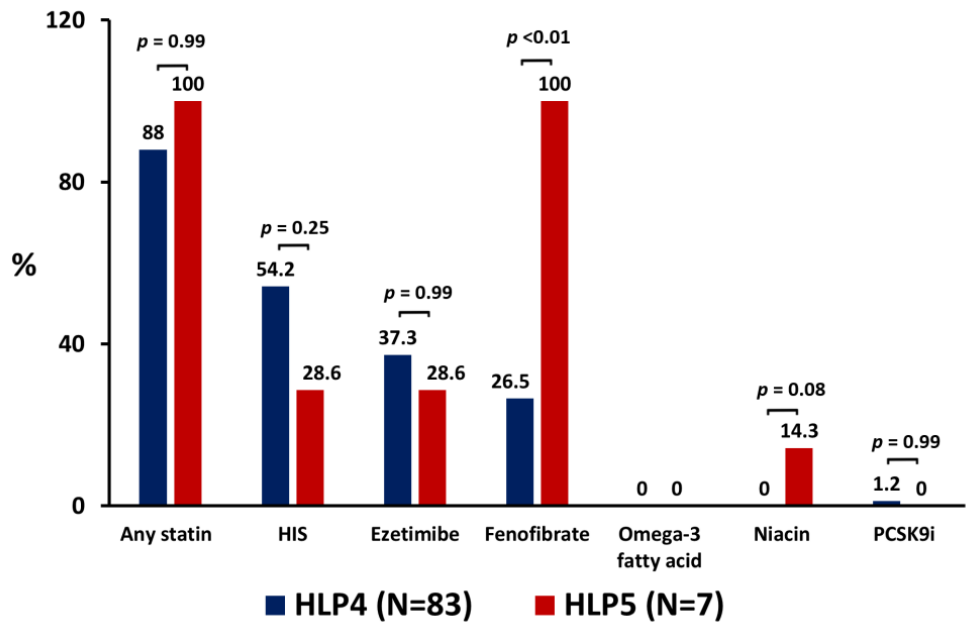
Figure 1. Prescription rates of LLT in patients with HLP4 and patients with HLP5 at the 6-month follow-up. HIS = high-intensity statin; HLP4 = type IV hyperlipoproteinemia; HLP5 = type V hyperlipoproteinemia; LLT = lipid-lowering therapy; N = number; PCSK9i = proprotein convertase subtilisin/kexin type 9 inhibitor ( p value was calculated as HLP5 vs. HLP4). There were no patients lost follow-up during the 6-month observation. Only one pa- tient with HLP4 had no data of plasma LDL-C, HDL-C, and apoB levels at the 6-month follow-up. Following 6 months of treatment, patients with HLP5 had similar TC (173.4 ± 35.5 mg/dL vs. 150.0 ± 36.1 mg/dL; p = 0.09), LDL-C (79.4 ± 35.4 mg/dL vs. 79.8 ± 28.2 mg/dL; p = 0.91), and apoB (88.4 ± 26.2 mg/dL vs. 79.3 ± 20.1 mg/dL; p = 0.26) levels com- pared with patients with HLP4 (Figure 2). However, patients with HLP5 still had persis- tently higher TG (440.1 ± 239.0 mg/dL vs. 173.9 ± 94.8 mg/dL; p <0.01), lower HDL-C (33.1